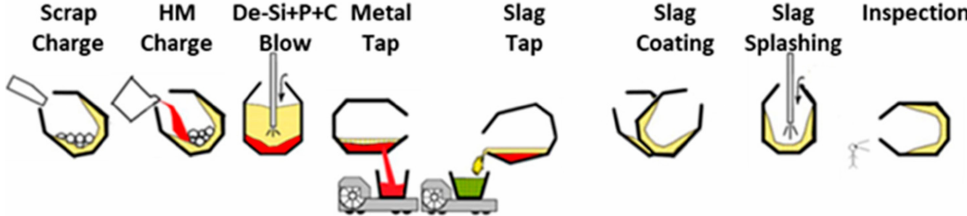
Figure 11. Straight-blow with slag splashing practice